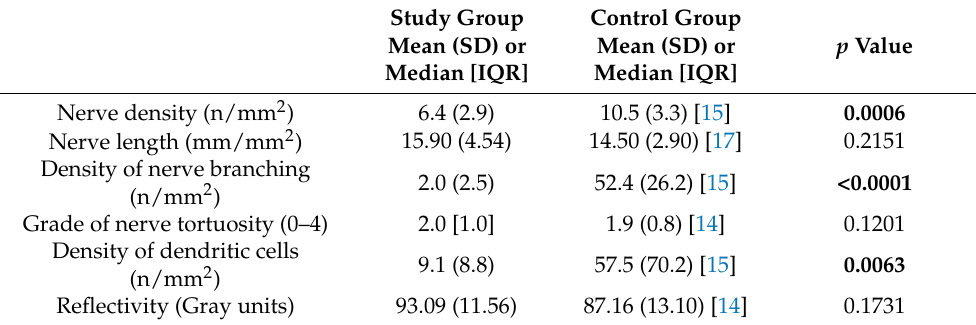
Table 4. Comparison of morphologic cornea parameters obtained by in vivo confocal microscopy in the mercury-intoxicated study group and control values from our group and published literature [14,15,17]. Study